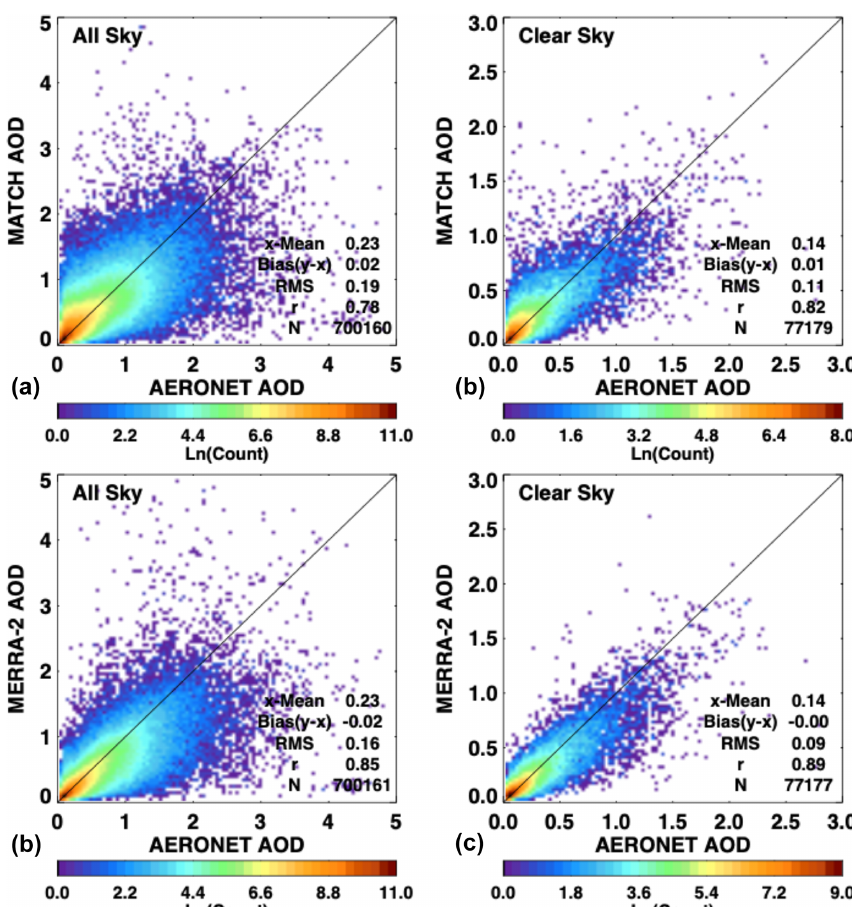
Figure 8. All-sky (a, c) and clear-sky (b, d) comparisons of observed (AERONET) hourly mean optical depths to estimates from the MATCH model for more than 20 years at the 55 AERONET sites shown in Fig.